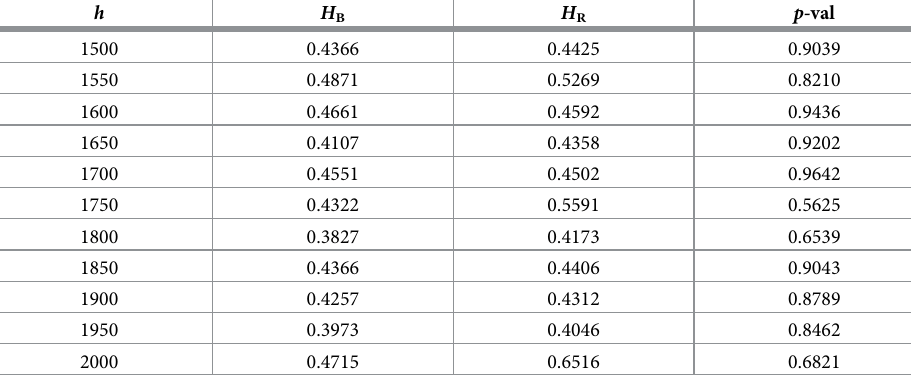
Table 7. Spectral analysis of mung beans and reference signal as p -values.